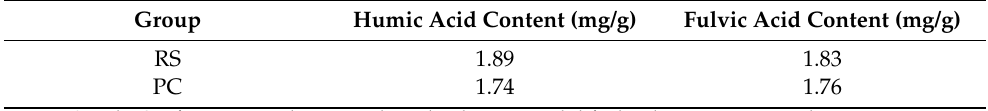
Table 3. Content of humic acid and fulvic acid in solidified sediment. Group Humic Acid Content (mg/g) Fulvic Acid Content (mg/g) RS 1.89 1.83 PC 1.74 1.76 Note: RS and PC refer to raw sediment and Portland cement solidified sediment, respectively.